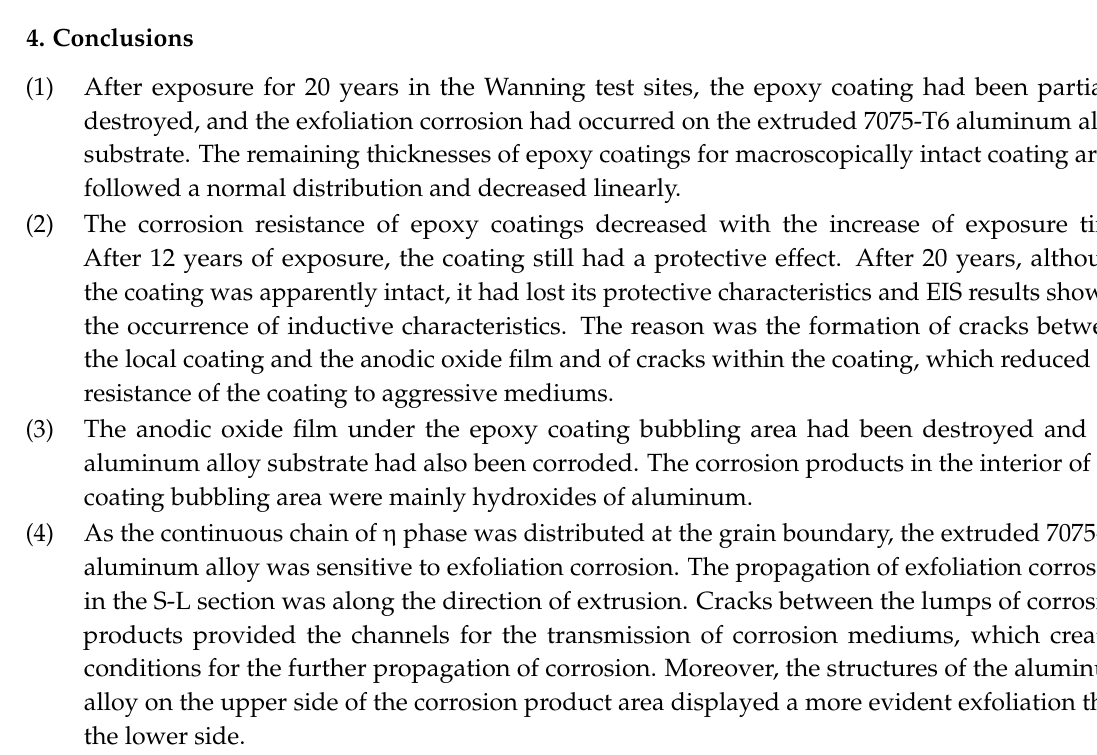
Figure 14. Mechanical model of wedge exfoliation analysis.